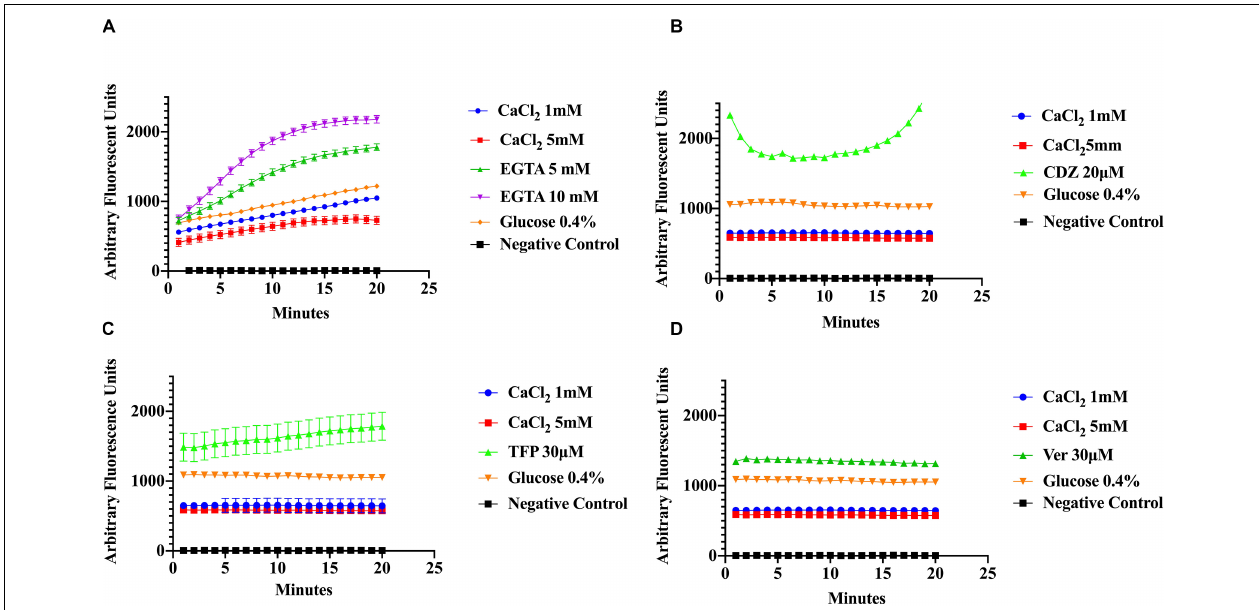
FIGURE 3 | Ethidium bromide accumulation in response to calcium and calcium inhibitors at pH 7. S. aureus cells were preincubated in the presence of Ca 2 + (1 mM and 5 mM), Ca 2 + chelator EGTA (5, 10 mM), the phenothiazine trifluoperazine (TFP 30 µ M), the Ca 2 + -channel blocker verapamil (Ver 30 µ M), and the Ca 2 + -Calmodulin inhibitor Calmidazolium (CDZ 20 µ M). The results show that calcium enhances the efflux of Ethidium Bromide in S. aureus (A) effect of CaCl 2 , EGTA, and glucose (4%) on ethidium bromide accumulation at pH 7.6 on S. aureus. (B) The effect of CaCl 2 , CDZ, and glucose on ethidium bromide accumulation at pH 7 on MRS A cells. (C) Effect of CaCl 2 , TFP and glucose on ethidium bromide accumulation (pH 7). (D) The effects of Ver, CaCl 2 , and glucose on EtBr efflux (pH 7). The results represent the average of three replicates at each time point. Significant differences were seen between calcium, inhibitor treatments and controls ( p < 0.0001) Kruskal–Wallis,